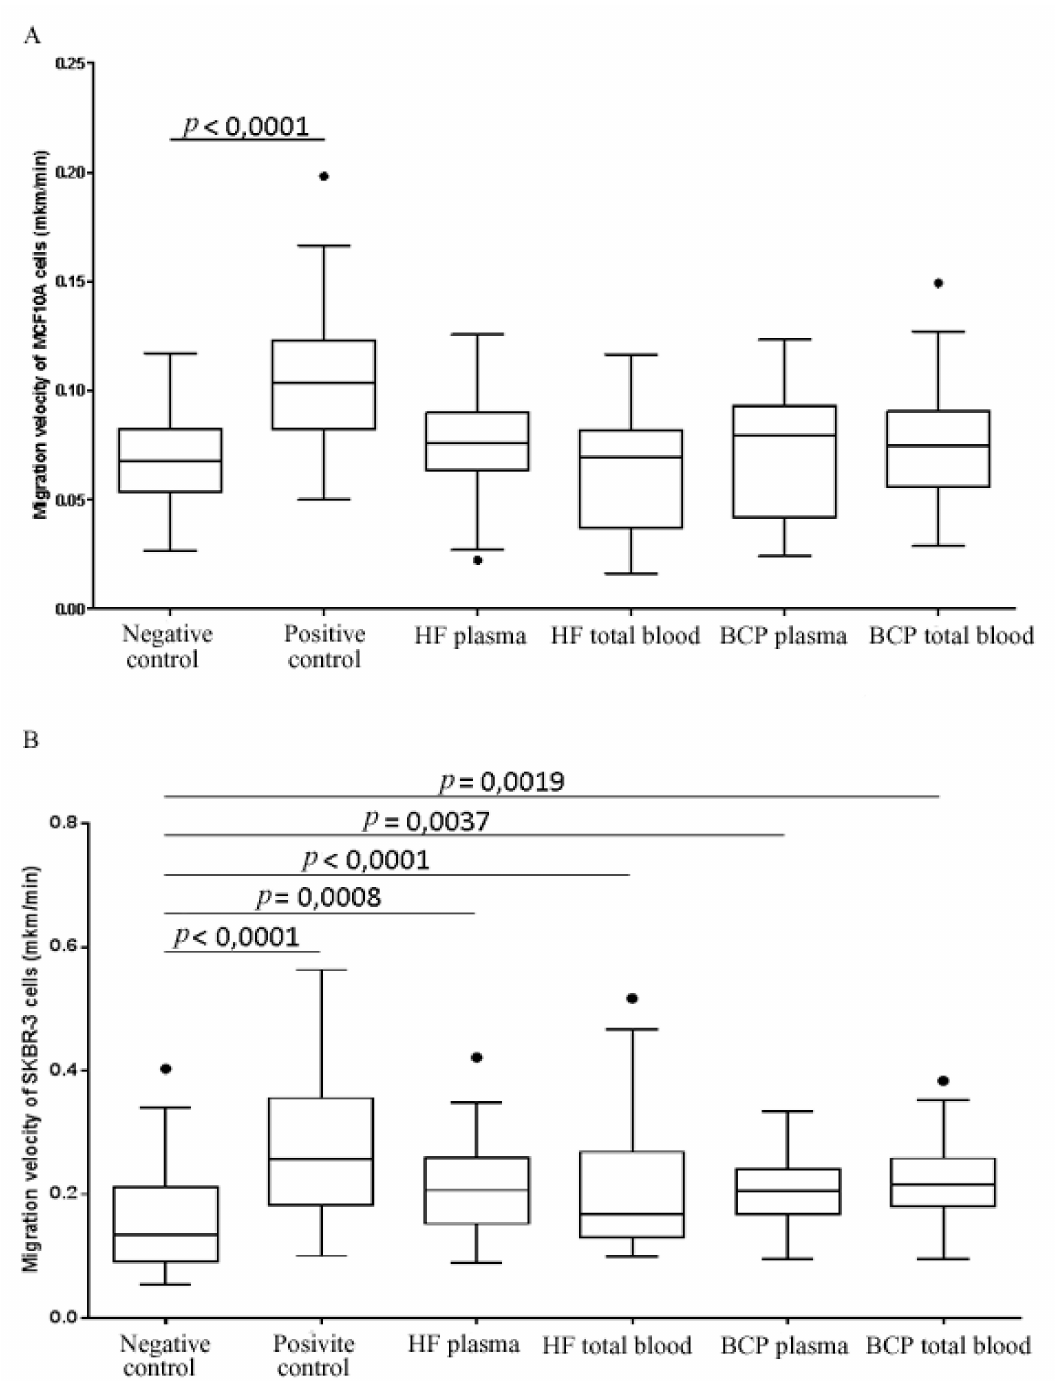
Figure 2. The velocity of migrating MCF10A ( A ) and SKBR-3 ( B ) cells under specified conditions. Results are presented as Tukey box plots. Median (-) velocity with 25–75% ( (cid:3) ) and non-outlier range bars are